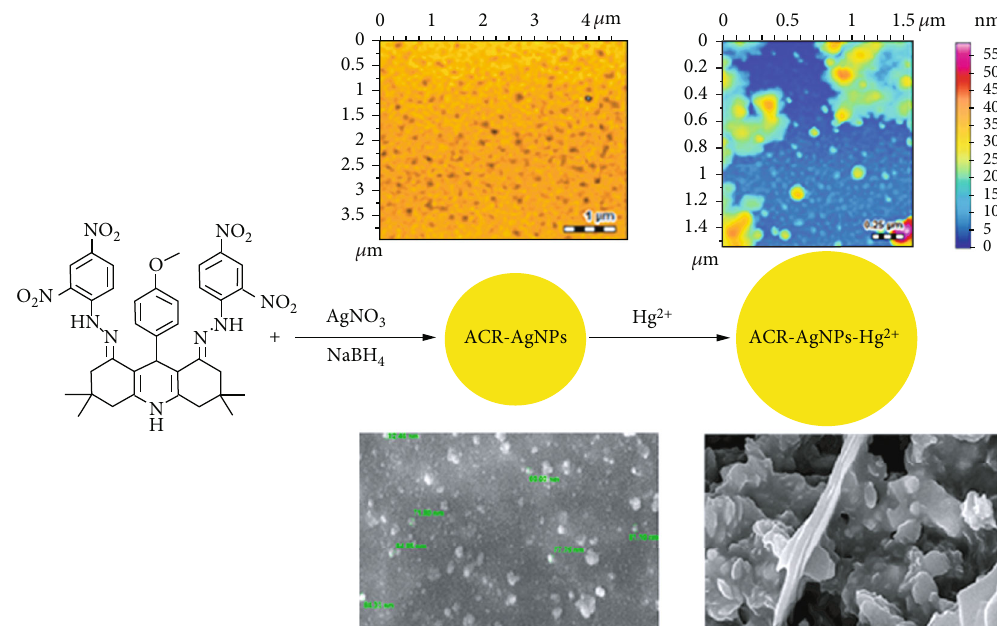
Figure 1: Graphical presentation of present